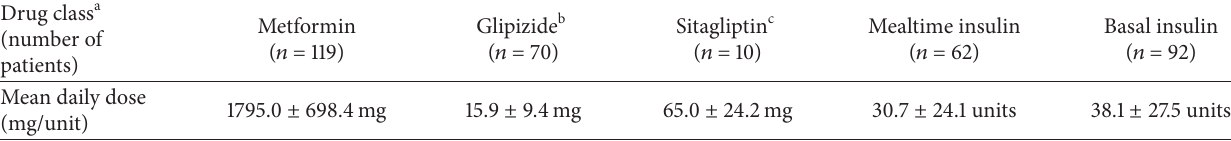
Table 2: Mean daily dose of oral hypoglycemic agents and insulin at baseline.